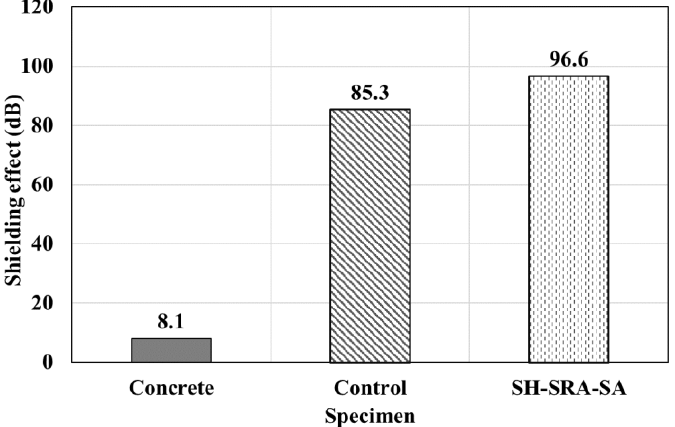
Figure 12. Results of shielding effect at 1000 MHz.